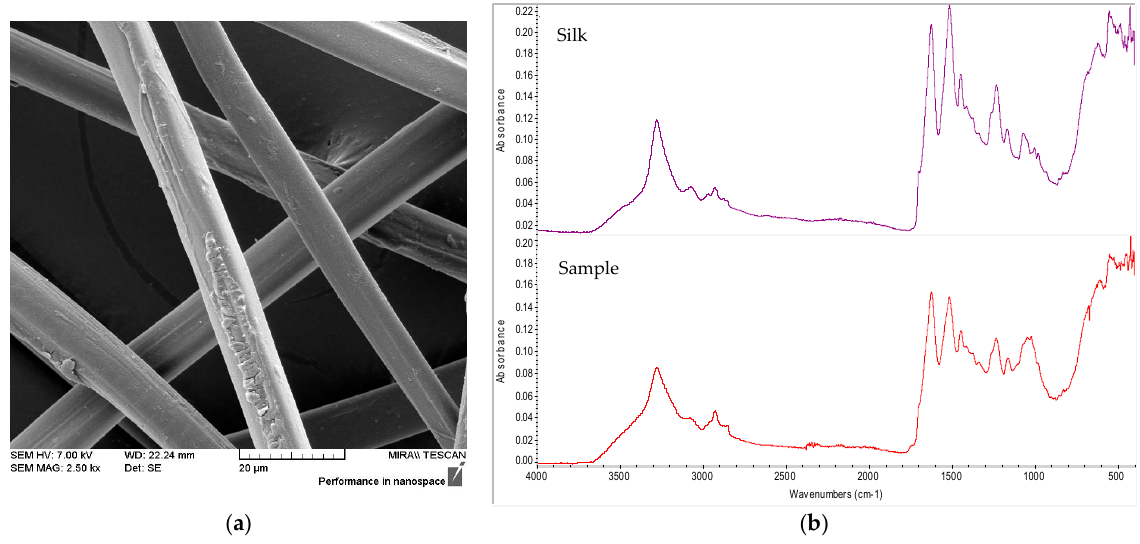
Figure 3. Silk warp from Fragment 2, Sample 7 : ( a ) SEM photograph; ( b ) FTIR-ATR spectra of reference silk and sample (red).